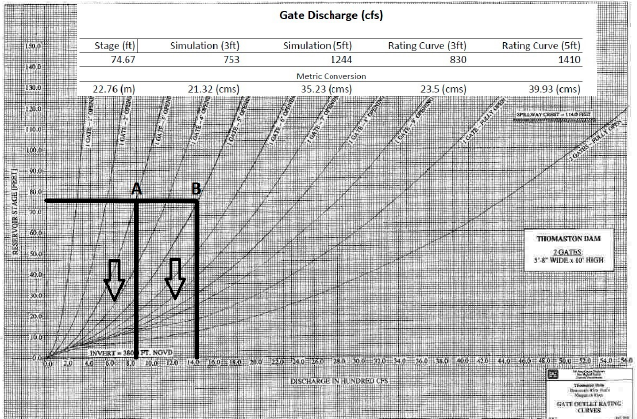
Figure 6. Model simulated gate discharge validated against Thomaston Dam posted ratings curves. Line A represents the intersection between the maximum flood stage (22.76 m or 74.67 ft) and the rating curve for one gate that is 3 ft open. Line B represents the intersection between the maximum flood stage and the rating curve for one gate that is 5 ft open.